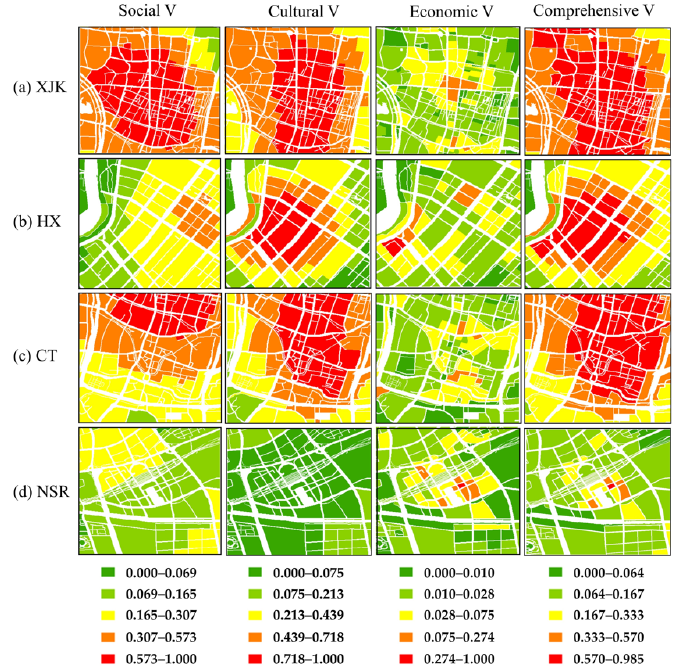
Figure 12. Distribution of vitality revealed based on different data.